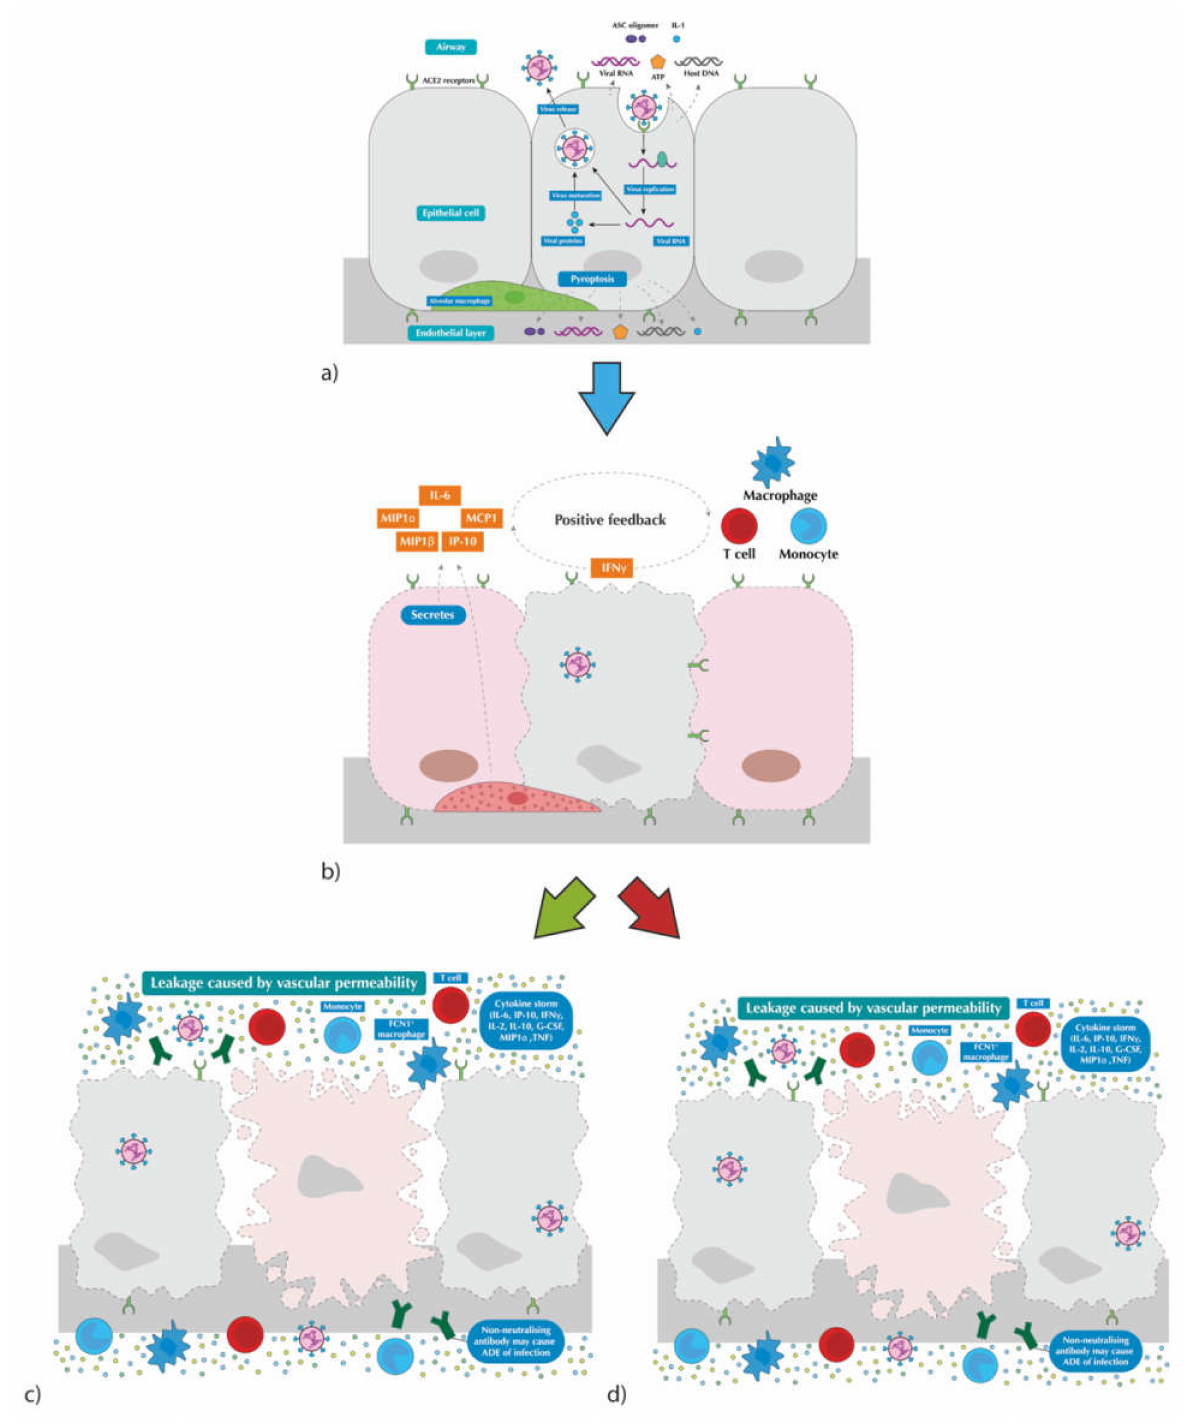
Figure 1. Pathogenesis of COVID-19. ( a ) Following the infiltration of host cell, SARS-CoV-2 under- goes replication and maturation leading to pyroptosis and release of damage-causing molecules; ( b ) secretion of pro-inflammatory cytokines and chemokines recruit immune cells, eventually setting up a positive feedback loop; ( c ) activated T-cells eradicates infected cells; ( d ) dysfunctional immune responses cause an overproduction of cytokines resulting in a damaging ‘cytokine storm’ leading to widespread inflammation and bystander tissue damage. (edited)